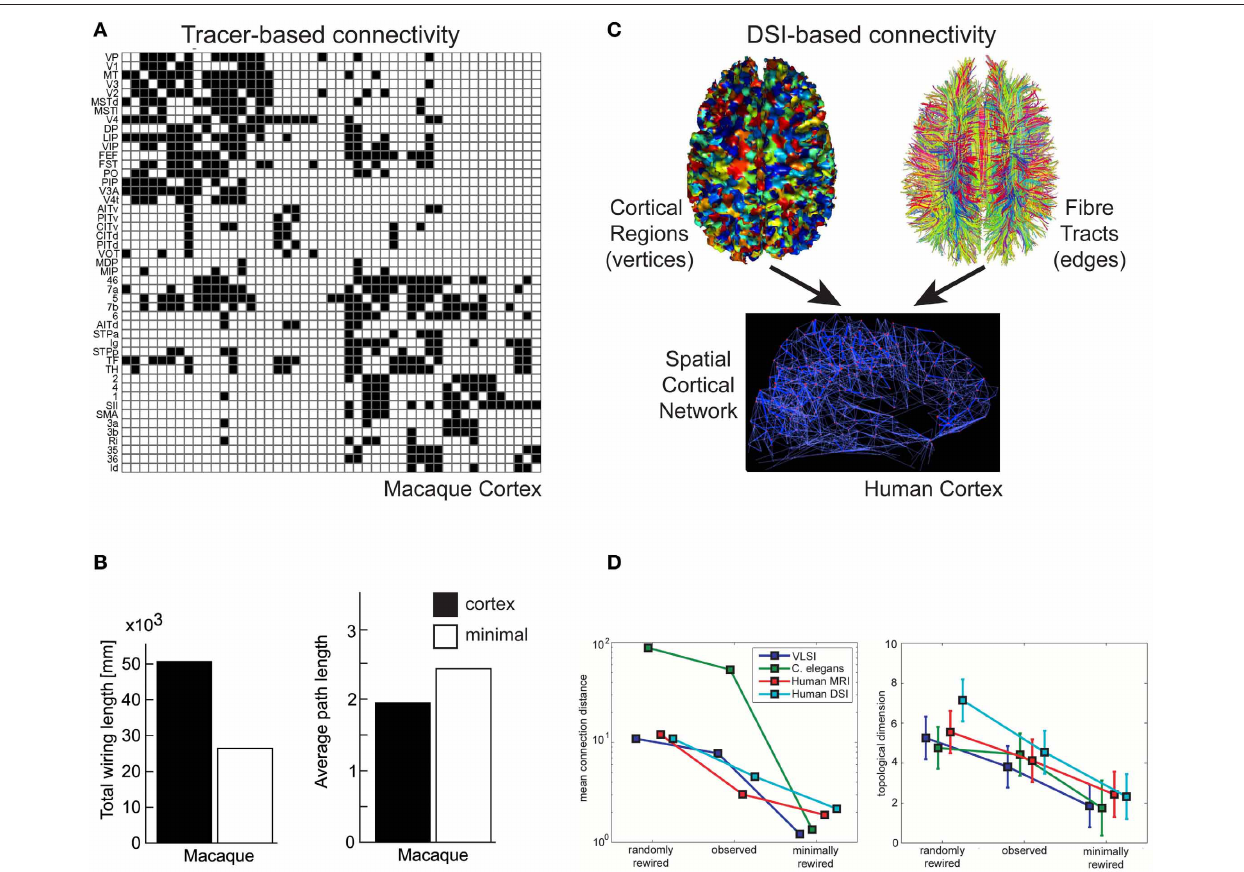
FIGURE 5 | Communication cost trade-off at Pathway scale of cortical organization. (A,B) Macaque tracer-derived pathway connectivity. (A) Example of directed connectivity (adjacency) matrix of visual and somatomotor macaque cerebral cortex (Reprinted from Sporns et al., 2007), where black squares indicate evidence supporting a axonal pathway connection between areas (matrix rows as sources and columns as target cortical regions). (B) Macaque cerebral cortical network is suboptimal for total axonal length (left) but minimal length network increased averaged path length (right) (Reprinted from Kaiser and Hilgetag, 2006). (C,D) Human